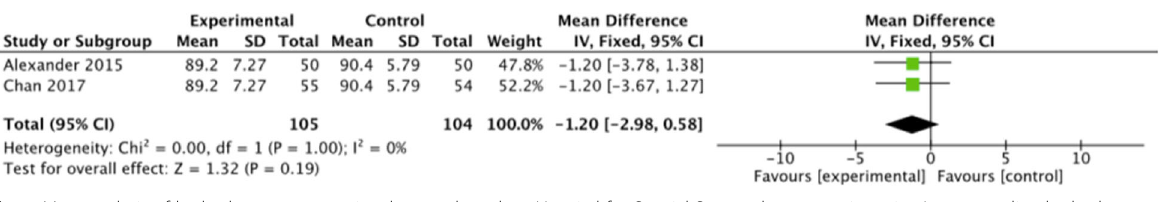
Fig. 7 Meta-analysis of barbed versus conventional suture based on Hospital for Special Surgery knee questionnaire. In two studies, barbed suture (105 cases) versus conventional suture (104 cases) showed no significant association (OR -1.20 [95% CI, − 2.98, 0.58]) (Test for overall effect, p = 0.19) with regards to Hospital for Special Surgery